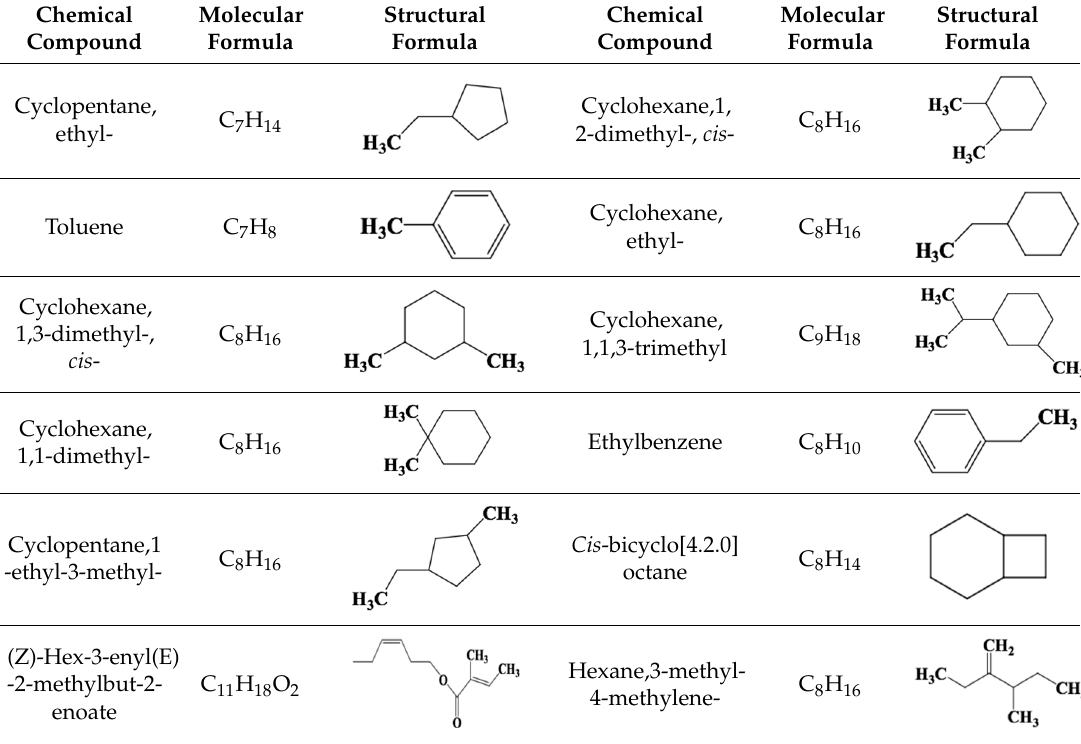
Table 3. Compound shell containing extracts of almond shells.